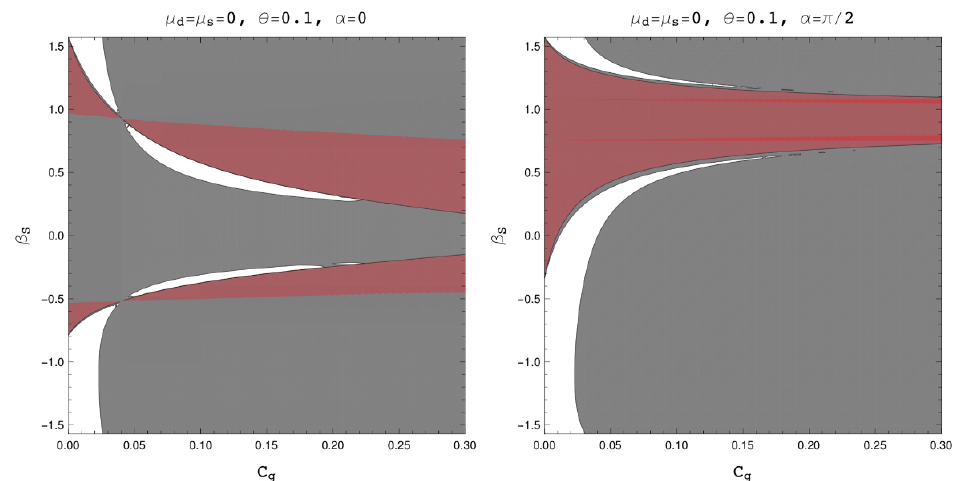
Figure 4 . Allowed regions in the D L - S R case, for (cid:22) d = (cid:22) s = 0 and (cid:18) = 0 : 1. We consider both (cid:11) = 0 (left) and (cid:11) = (cid:25)= 2 (right). As before, the grey regions indicate that some neutral scalar becomes tachyonic, while the red shading signals the presence of charged